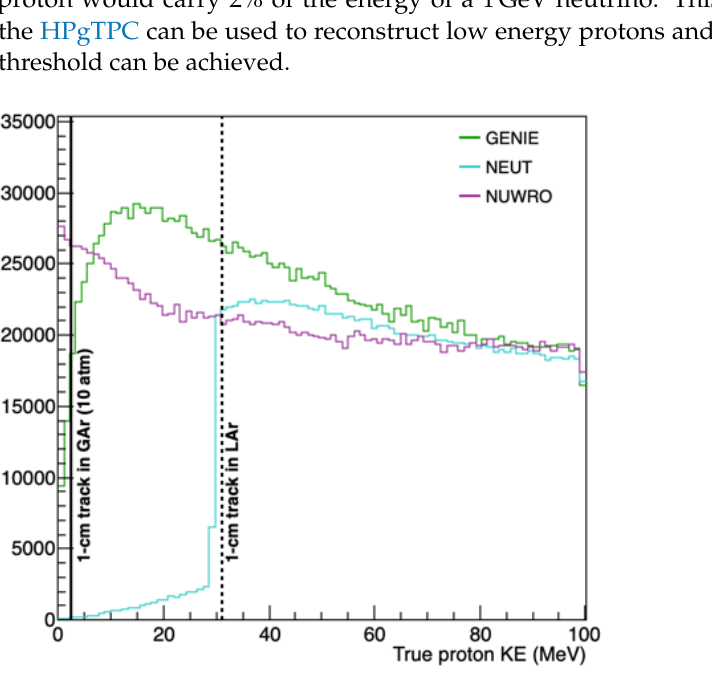
Figure 65. Predicted proton energy spectra from GENIE, NEUT, and NUWRO at low energies (truncated at 100MeV). The dashed vertical line indicates the kinetic energy required to make a 1 cm track in a LArTPC, and the solid vertical line shows the same for a gaseous TPC at 10 atm. The lower threshold in ND-GAr provides a unique opportunity to distinguish among final state interaction models for the same nuclear target as the ND and FD